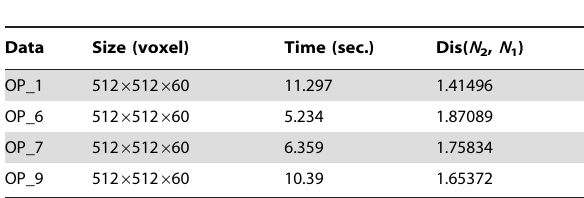
Table 1. Reconstruction time and